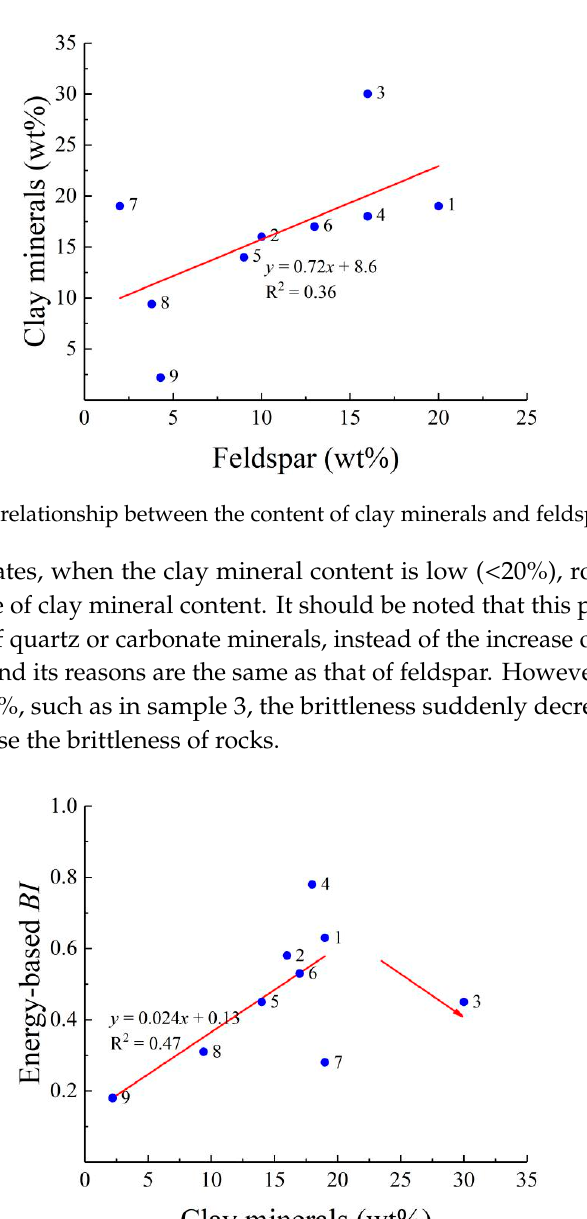
Figure 14. The relationship between energy-based BI and feldspar content.